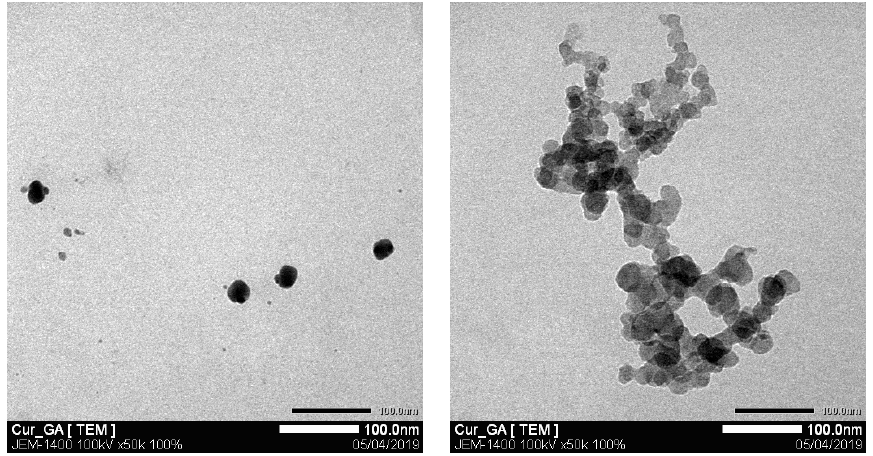
Figure 10. Morphology, structure and size of the curcumin nanosuspension analyzed by TEM.